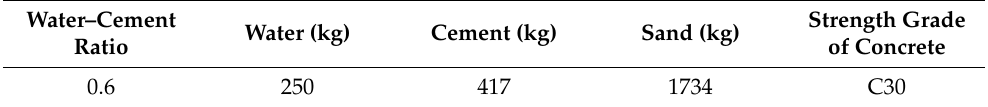
Table 2. Mix proportions of the test concrete.